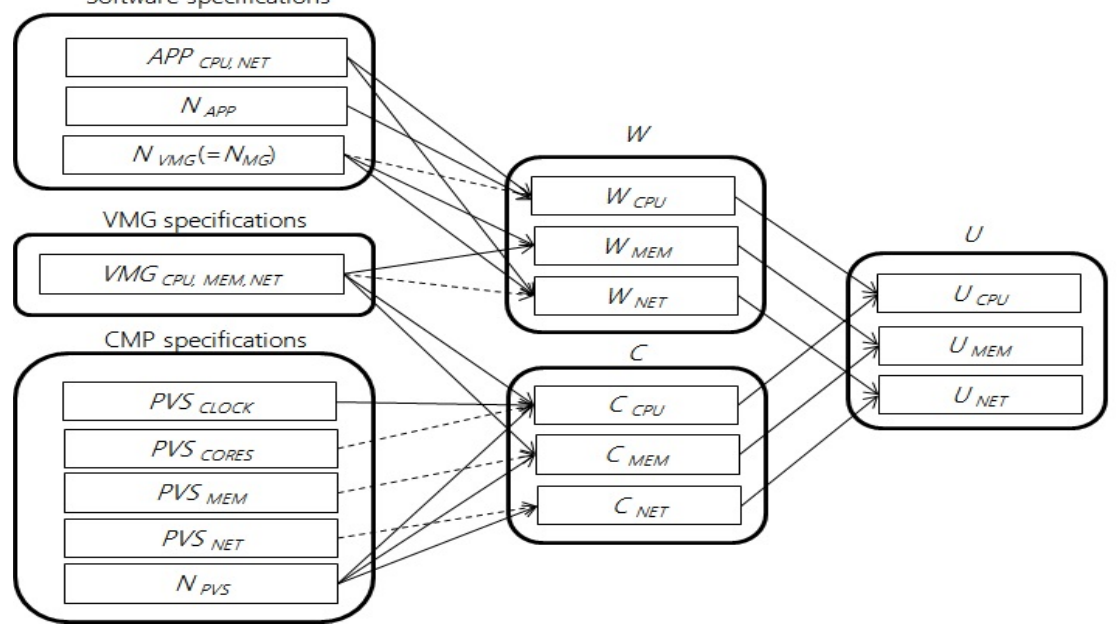
Figure 5. Mapping of impacts among W, C, and U.